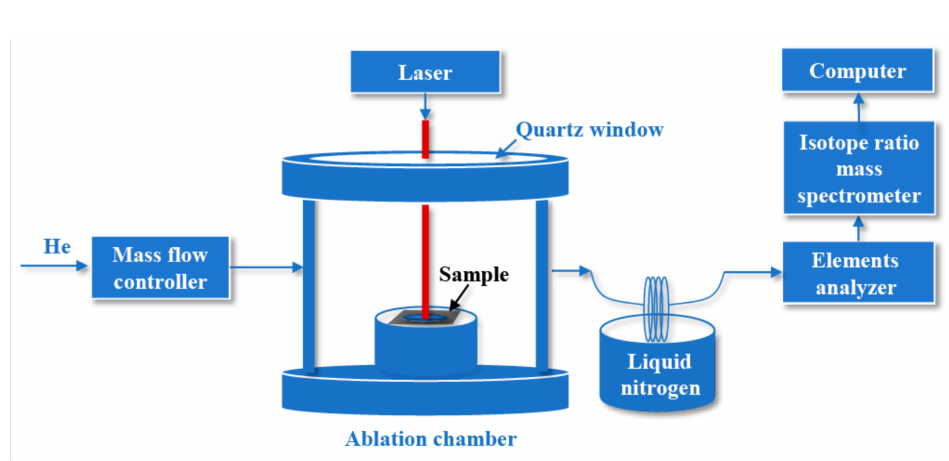
Figure 2. Diagram of the laser ablation isotope ratio mass spectrometry